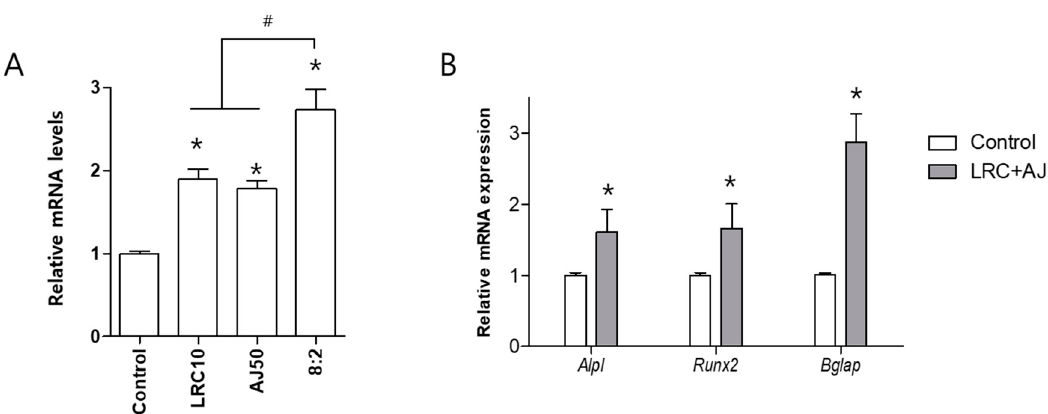
Figure 3. E ff ects of LRC and AJ extract on mRNA expression of bone formation markers ( Alpl , Runx2 and Bglap ) in MC3T3-E1 cells. ( A ) Cells were treated with single extracts of LRC and AJ and combined LRC and AJ, with an 8:2 ratio at 10 µ g / mL. Total RNA of the cells was extracted and then the mRNA expression level of Bglap was compared by quantitative reverse-transcription polymerase chain reaction (qRT-PCR). ( B ) The mRNA expression of Alpl, Runx2 and Bglap was confirmed in the combined LRC and AJ extracts. The mRNA levels of bone formation markers were normalized by mRNA expression of Gapdh (glyceraldehyde 3-phosphate dehydrogenase). Control: non-treated cells. *: p < 0.05 vs. Control and #: p < 0.05 vs. 8:2.